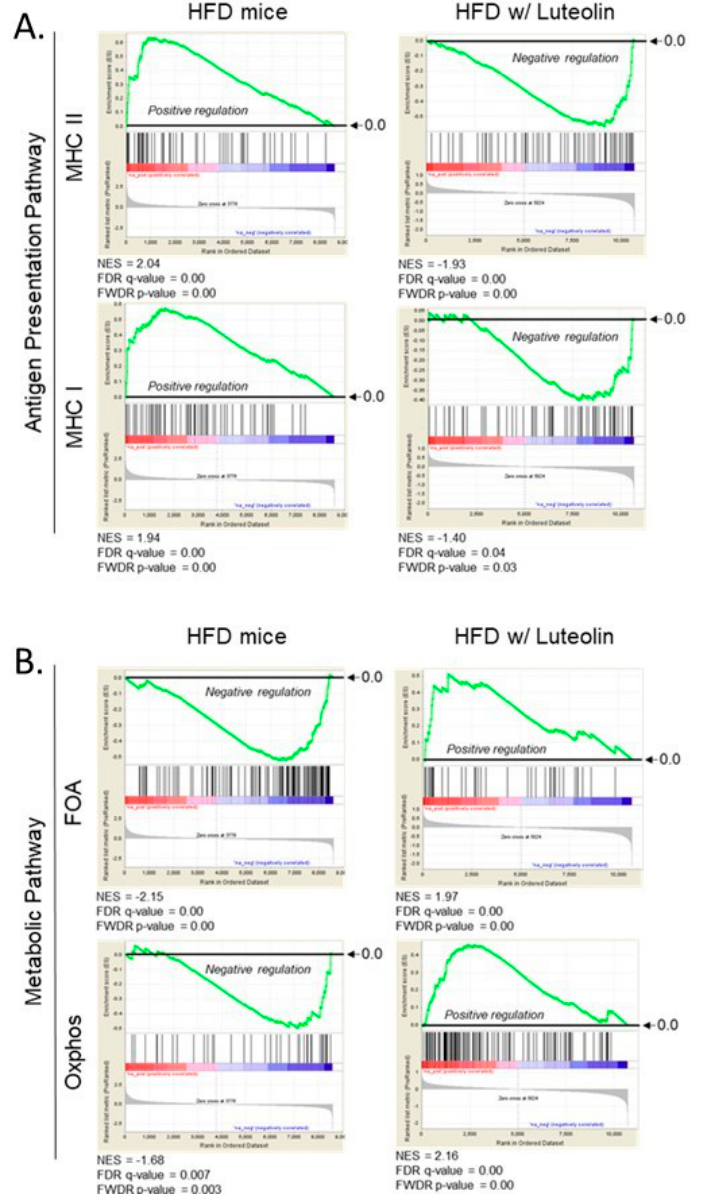
Figure 2. Gene Set Enrichment Analysis (GSEA) of antigen presentation pathways ( A ) and metabolic pathways ( B ) in high-fat-diet mice with/without luteolin treatment. ( A ) Expression of MHC-I and MHC-II gene sets in high-fat-diet mice with and without luteolin treatment; ( B ) Expression of FAO and Oxphos gene sets in high-fat-diet mice with and without luteolin treatment. FDR, false discovery rate; FWER, family wise error rate; NES, normalized enrichment scores.